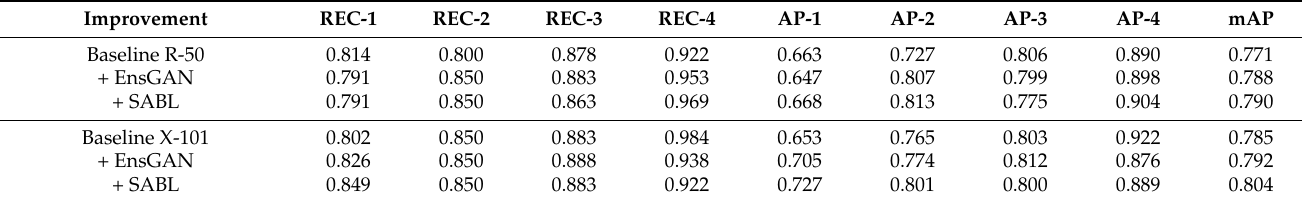
Table 3. The ablation improvement results of the proposed EnsGAN-SDD.